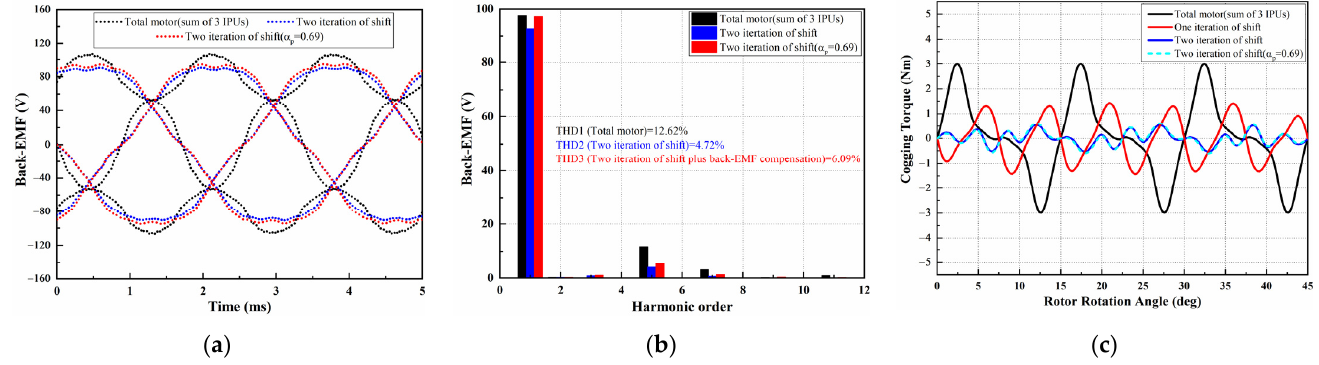
Figure 9. Back-EMF compensation of the 8P12S machine: ( a ) waveforms, ( b ) FFT, and ( c ) cogging torque after back-EMF compensation.